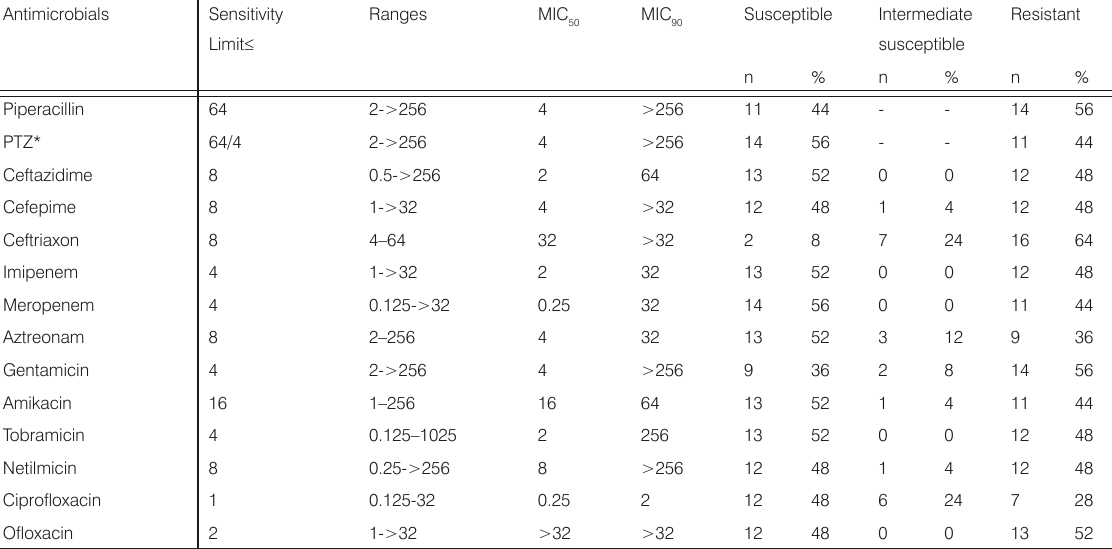
Table 1. The MIC (μg/ml) of Pseudomonas aeruginosa strains (n=25) against to 16 antimicrobials.